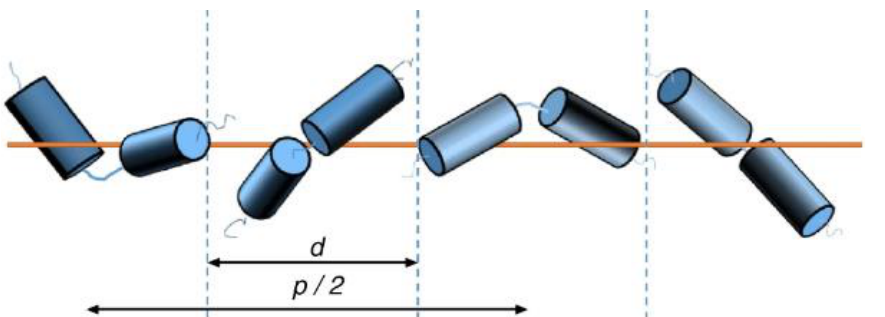
Figure 16. A schematic representation of the molecular arrangement within the SmC TB phase (taken from [3]).